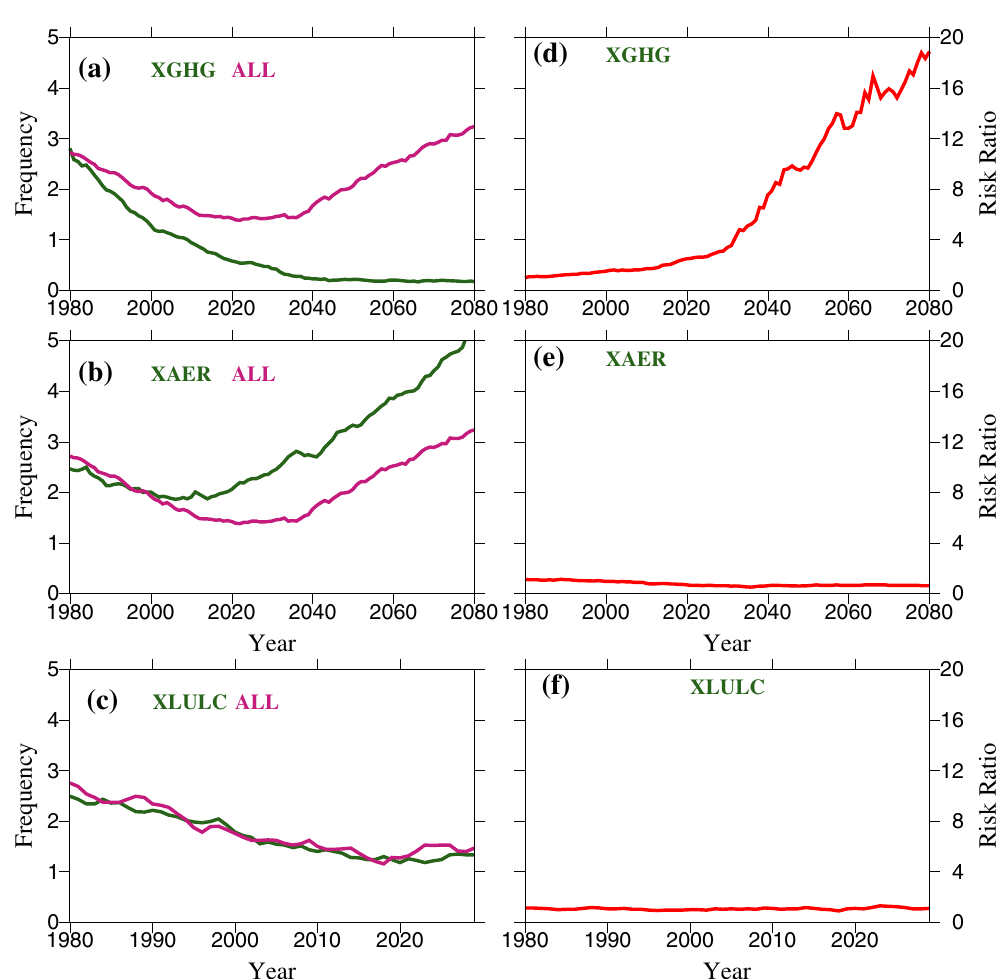
Fig. 6 The in fl uence of greenhouse gas emissions (GHG), industrial aerosols (AER), and land-use/land-cover (LULC) on concurrent hot and dry extremes during the summer monsoon season in India. a – c The frequency (per year) of concurrent hot and dry extremes under no greenhouse gas emission (XGHG), no industrial aerosols (XAER), and no land-use/land-cover change (XLULC) and under ALL (natural + anthropogenic forcing) scenarios for 1951 – 2080, 1951 – 2080, and 1951 – 2029 periods, respectively. d – f Risk ratio (frequency in the ALL/ frequency in XGHG/XAER/XLULC) estimated for XGHG, XAER, and XLULC and ALL scenarios. The effect of GHG, AER, and LULC was estimated using the single-forcing experiments from CESM for 20, 20, and 5 ensemble members,